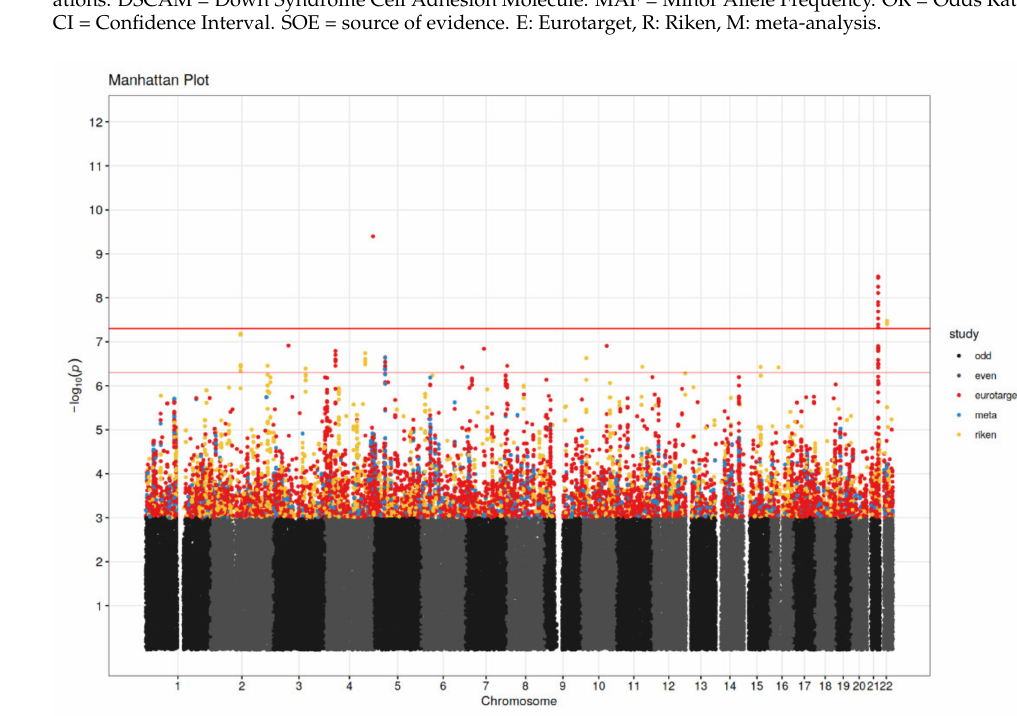
Figure 2. Manhattan plot for progression-free survival (PFS) analysis. Significance threshold (red horizontal line in bold) is set to p = 5 × 10 − 8 and p -values ≤ 5 × 10 − 7 (between red horizontal lines) were considered suggestive. Results are shown for EuroTARGET (red dots), RIKEN (green dots) and the meta-analysis (purple dots). Chromosomes are represented in odd numbers (black) and even numbers